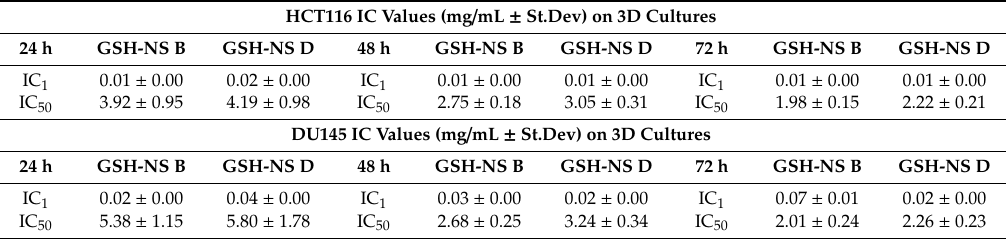
Table 3. GSH-NS IC values in the 3D cell